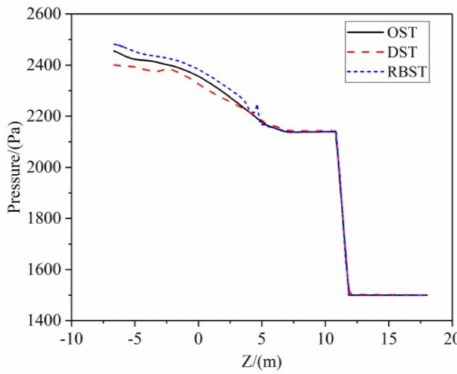
Figure 14. Pressure of central axis of